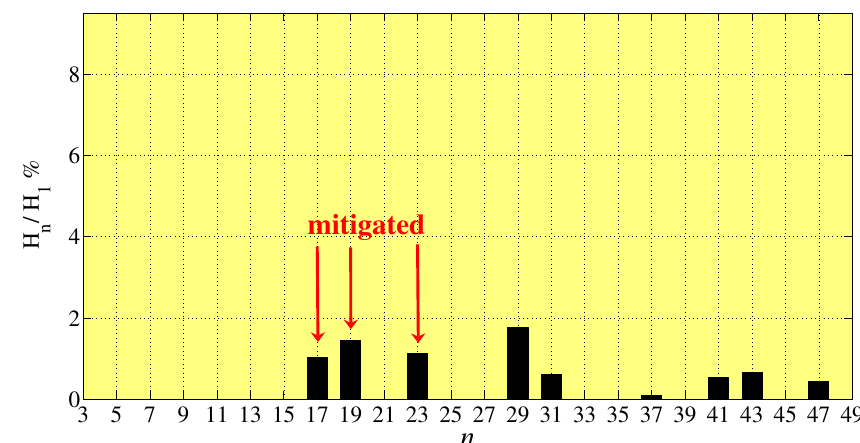
Figure 7. Percentage values of harmonics amplitudes H n with respect to the fundamental H 1 for three-phase 17-level